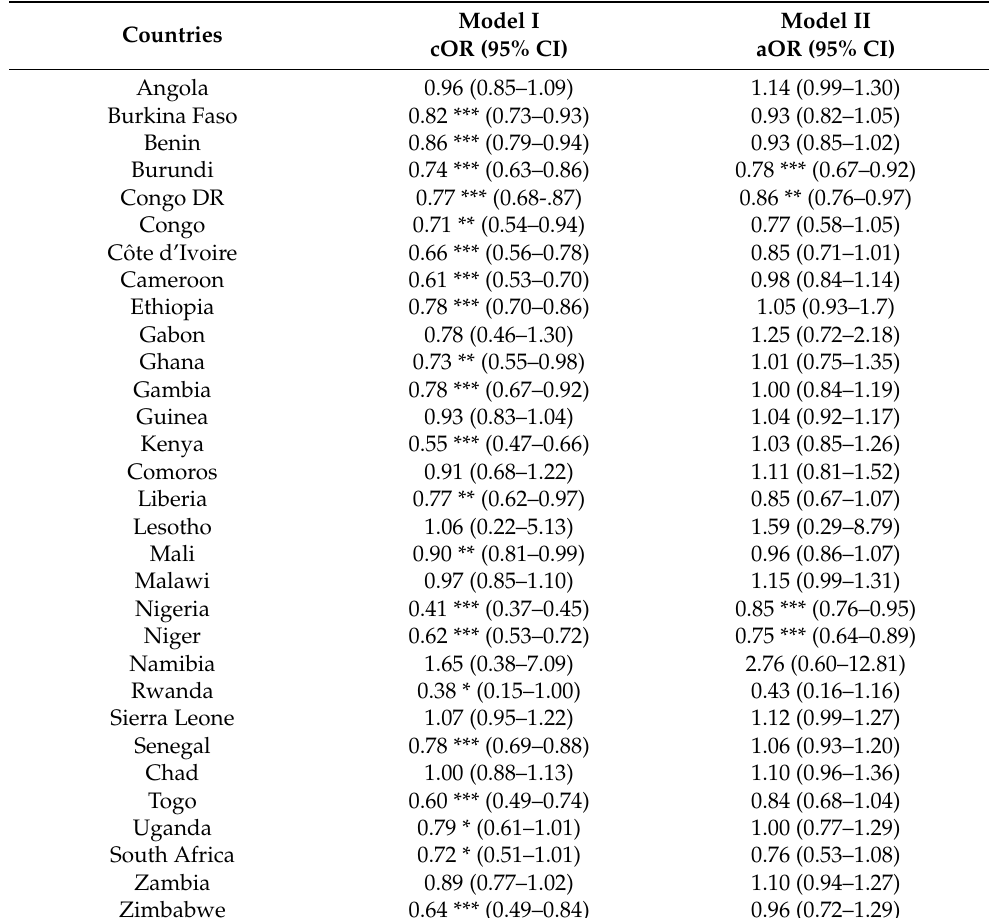
Table 4. Binary logistic regression results on the association between age at marriage and sexual autonomy among women in sub-Saharan Africa by